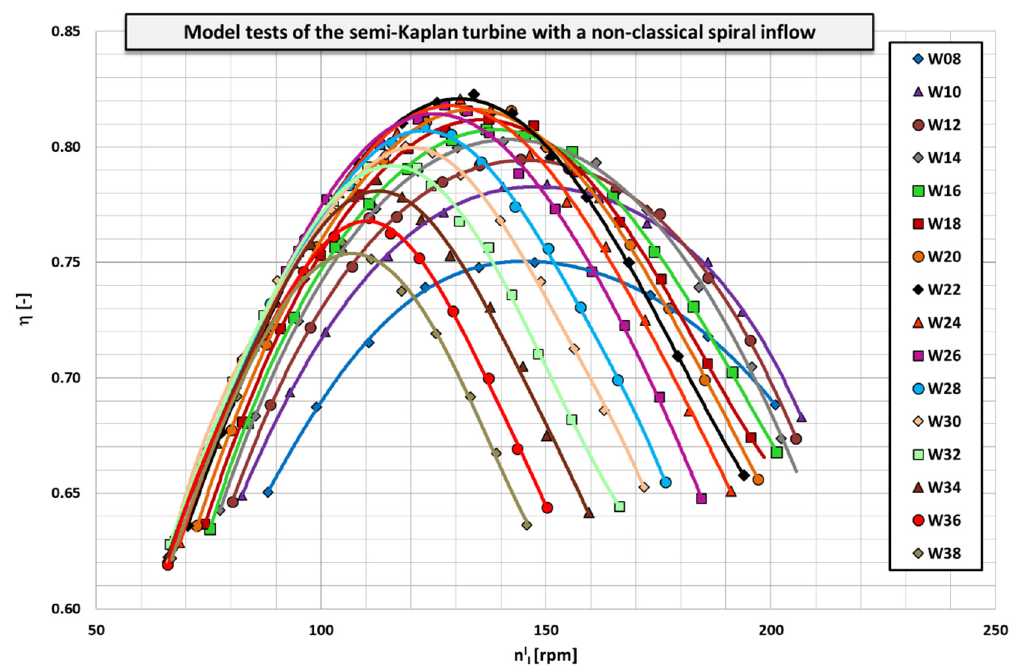
Figure 13. Efficiency curves of the model semi-Kaplan turbine as a function of the double-reduced rotational speed for the openings of the runner blades from 8° to 38° (in 2° steps).